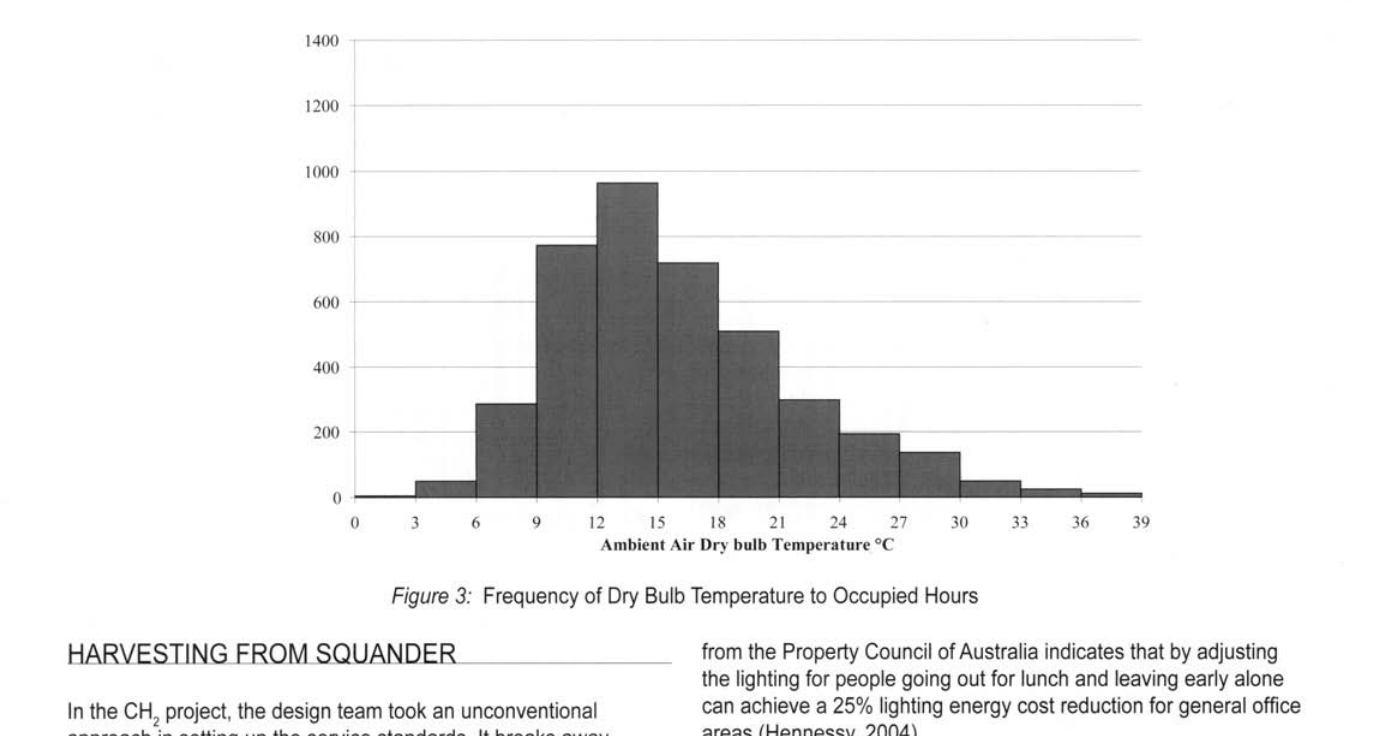
Figure 3: Frequency of Dry Bulb Temperature to Occupied